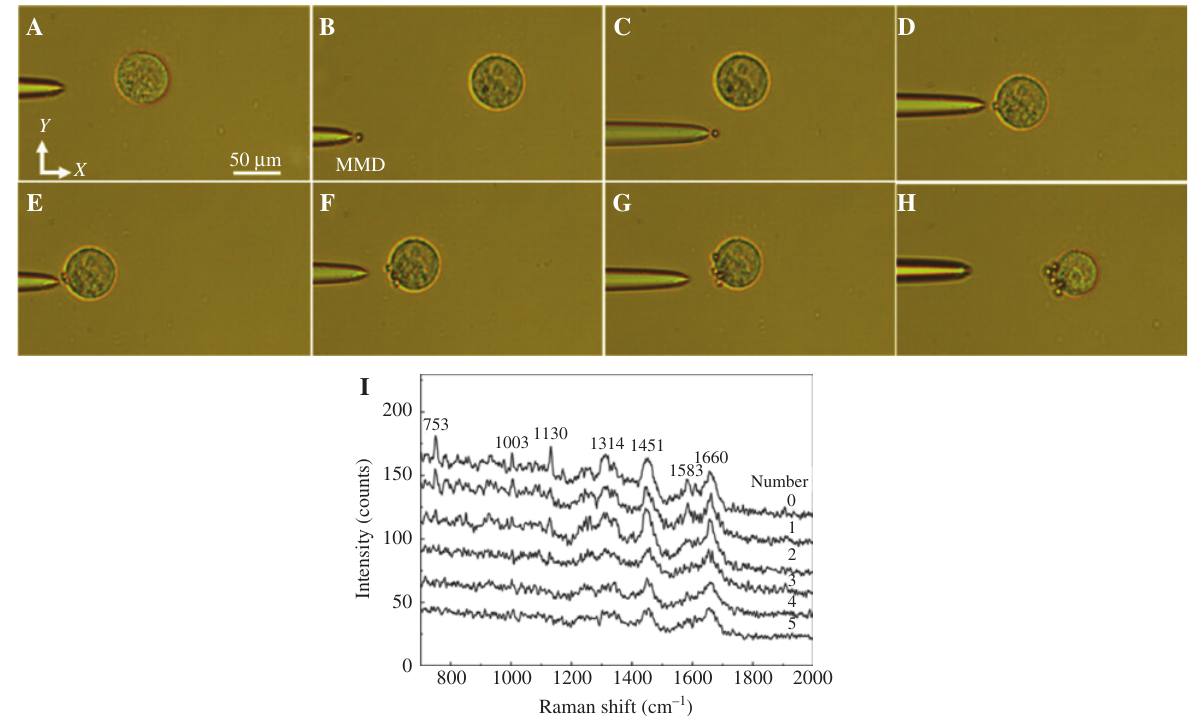
Figure 3: The optical microscope images of the delivery process of MMDs and the corresponding Raman spectrum of the targeted HeLa cell. (A) A HeLa cell was selected as the targeted cell, and no MMDs exist within a range of 1000 μ m of the targeted HeLa cell. The tip of the TFP was moved near the targeted cell to prepare for trapping and delivering MMDs. (B–D) The first trapped MMD was delivered to the position with distances of 115, 27 and 0 μ m from the targeted cell, respectively. (E–H) An additional four MMDs were successively trapped and delivered into the targeted cell by the TFP in the same time intervals (5 min). (I) The corresponding Raman spectrum of the targeted HeLa cell recorded real-timely by the Raman